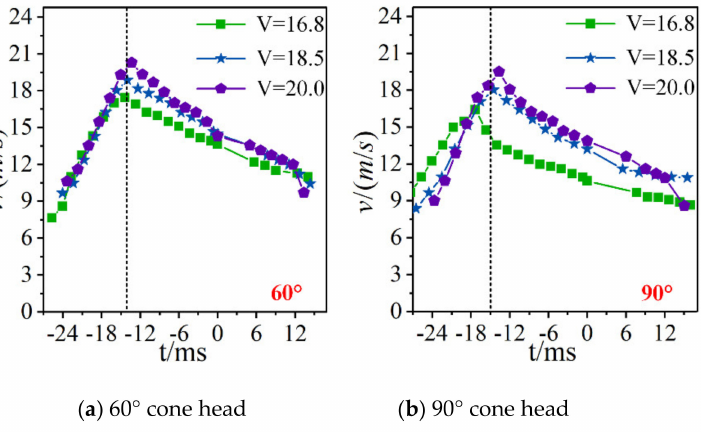
Figure 14. Variation curve of movement speeds of two head forms at three speeds. ( a ) 60 ◦ cone head ( b ) 90 ◦ cone head.